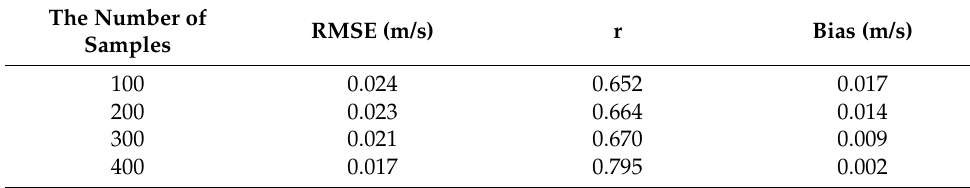
Table 6. Statistics of the estimation results under different sample